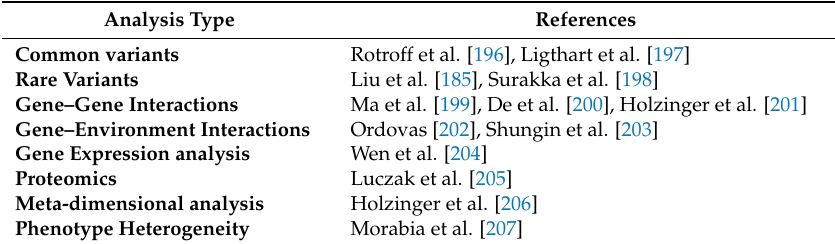
Table 2. Examples for use of different methods to exploit genetic architecture of lipid